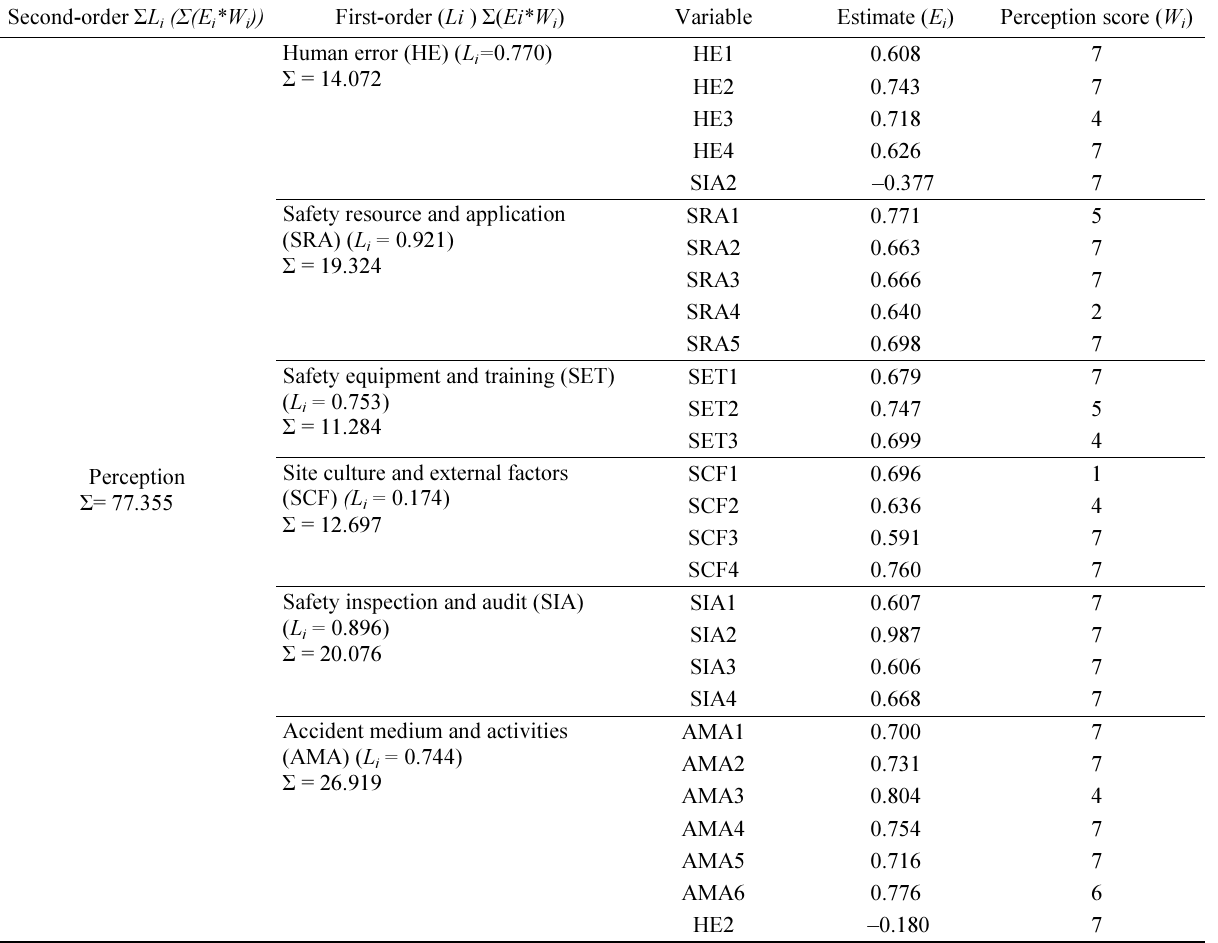
Table 8. Path effects and perception calculation example